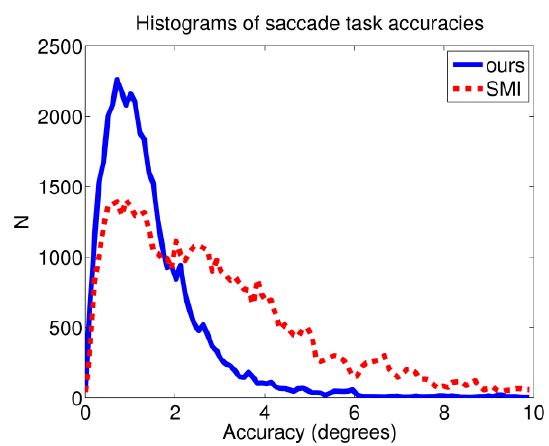
Figure 17. Histograms of accuracy values in the saccade task for both devices. Recordings ID06, ID07, ID11, and ID13 were excluded from the analysis. Lower accuracy value is better.